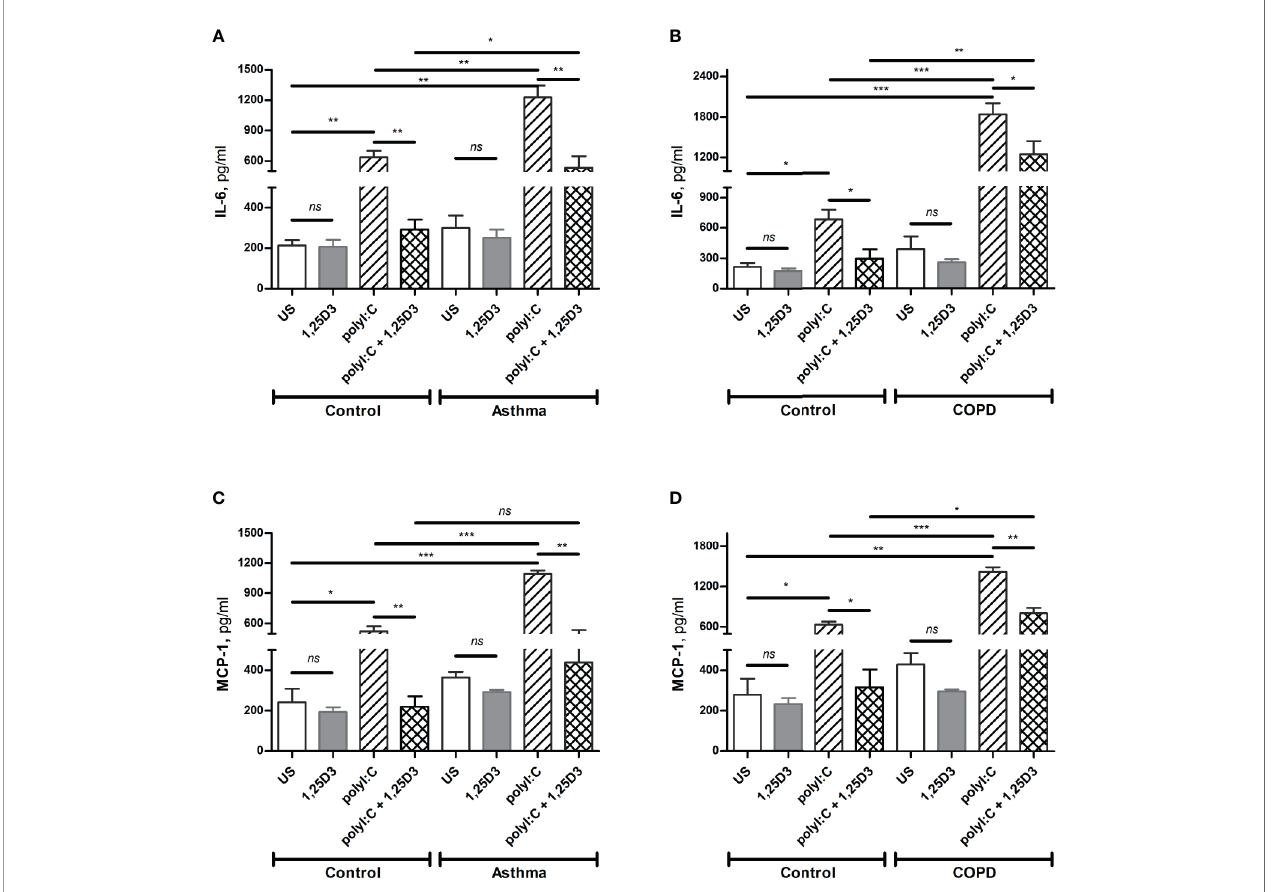
FIGURE 4 | Protein levels of IL-6 (A, B) , and MCP-1 (C, D) in BSMCs from asthma (A, C) and COPD (B, D) compared to BSMCs from healthy control groups were quanti fi ed by ELISA. n = 4 asthma, n = 3 healthy controls, n = 4 COPD, and n = 3 healthy control smokers. Data is representative of two independent experiments. One way ANOVA using Newman-Keuls multiple comparison test were performed to assess statistical signi fi cance between groups. Mean ± SE; ( ns ) p > 0.05, no signi fi cant difference, * p < 0.05, ** p < 0.01, *** p <